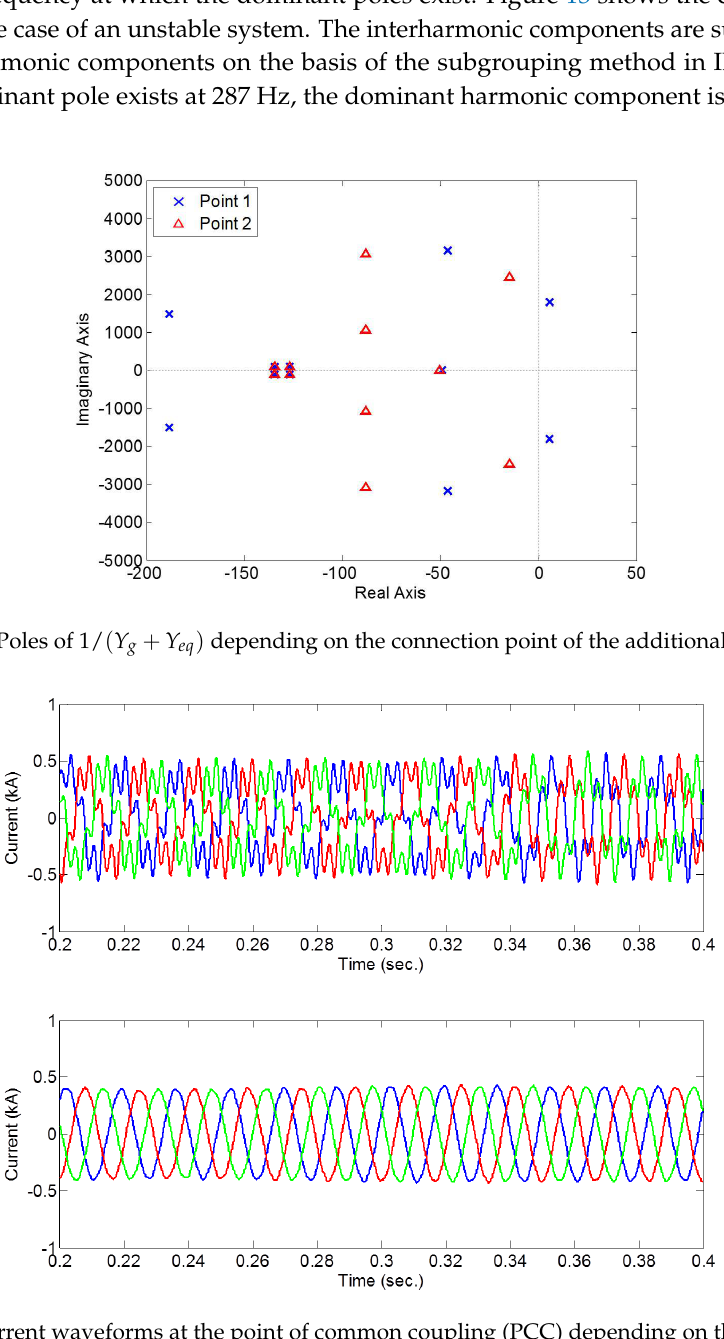
Figure 12. Current waveforms at the point of common coupling (PCC) depending on the connection point of the additional converter. The upper graph shows the case of connection to point 1, whereas the lower graph shows the case of connection to point